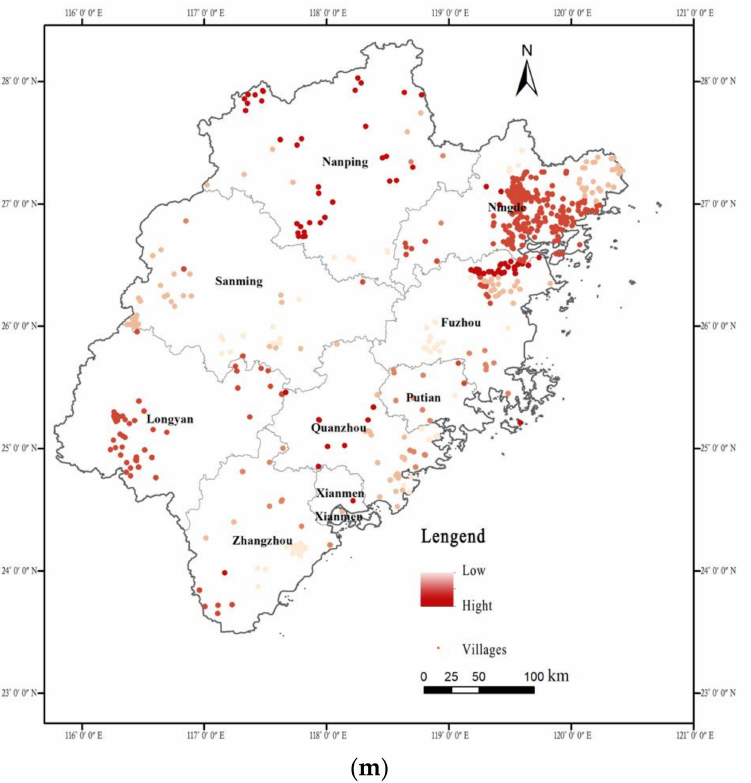
Figure 3. Superposition map of ethnic minority villages and influencing factors in Fujian Province: ( a ) Superposition of villages and altitude, ( b ) Superposition of villages and slope, ( c ) Superposition of villages and landslide areas, ( d ) Superposition of village and urbanization rate, ( e ) Superposition of village and economy, ( f ) Superposition of village and population, ( g ) Superposition of villages and roads, ( h ) Superposition of villages and river, (i ) Superposition of village and County Center, ( j ) Population of ethnic minorities in villages, ( k ) Quantity of village intangible cultural heritage, ( l ) Quantity of village material cultural heritage, and ( m ) Per capita cultivated land area of